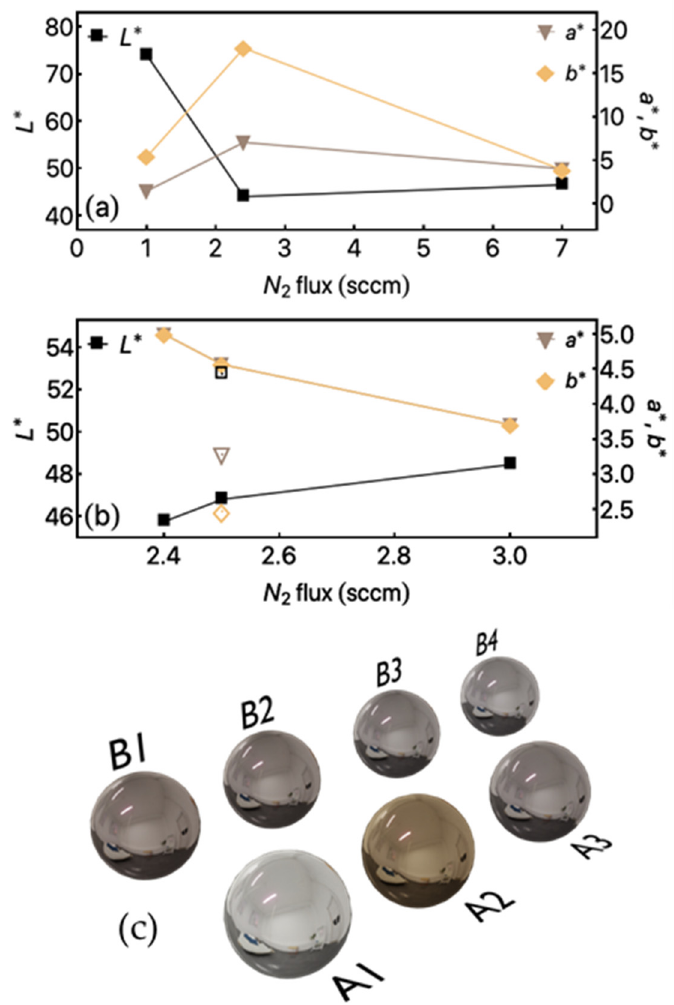
Figure 6. L*, a*, and b* factors for the studied films as a function of N 2 gas flow ( a ) TiN films (samples A1, A2, and A3). ( b ) Ti (N, C) films. The closed symbols depict the films in which 66 mm 2 of C pallets were used (samples B1, B2, and B3). The opened symbols depict the results obtained for Ti (N, C) films in which were used 132 mm 2 of C pallets (Sample B4). ( c ) Representation of the CIELab colors in a metallic system. For this representation, the CIELab color codes were converted in the hexadecimal code, and the results were simulated on the representative spheres.